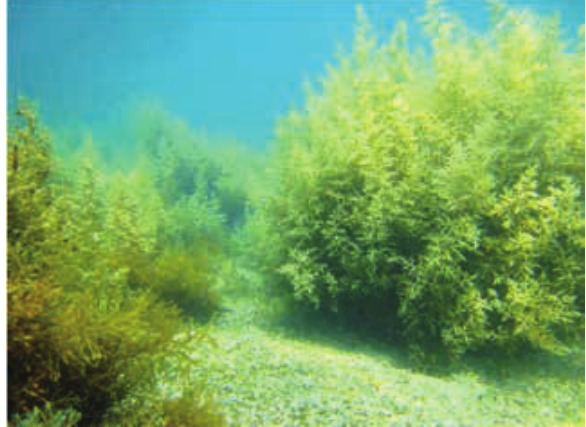
Faganeli in Malej: Obalni ekosistemi na prehodu: